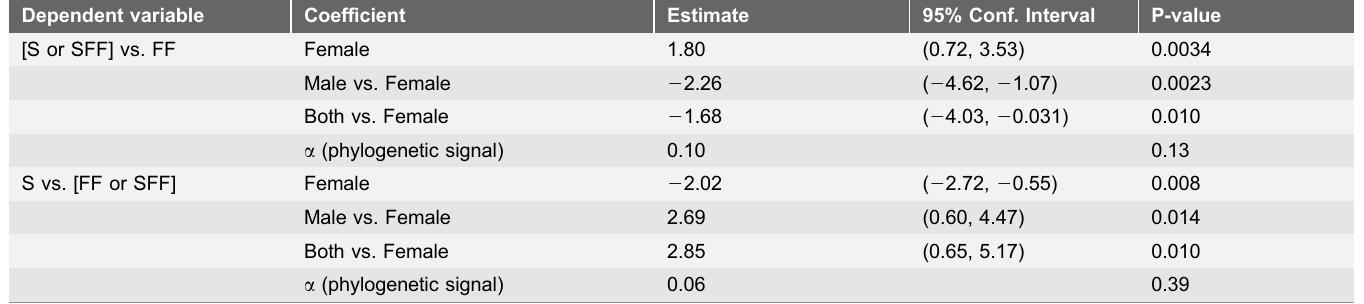
Table 1. Binary phylogenetic regression of Grouping on Dispersal regime.